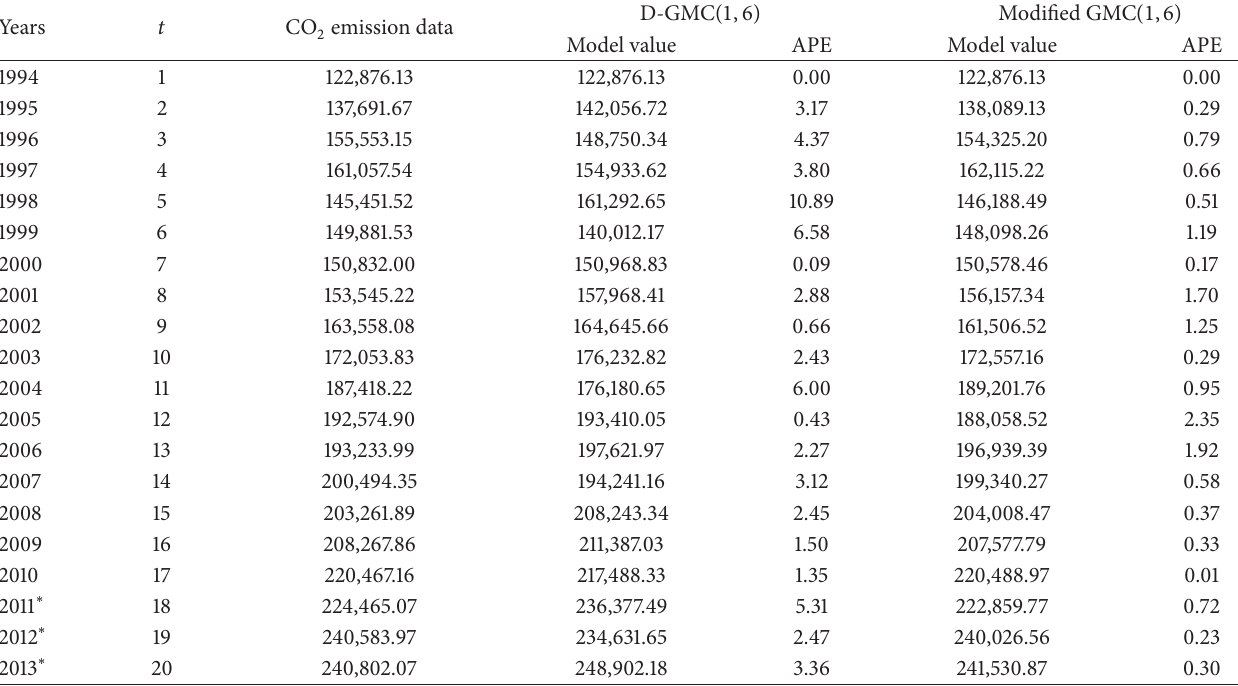
Table 2: Comparison of actual values, model values, and APEs of D-GMC (1,6) and modified GMC (1,6) models.